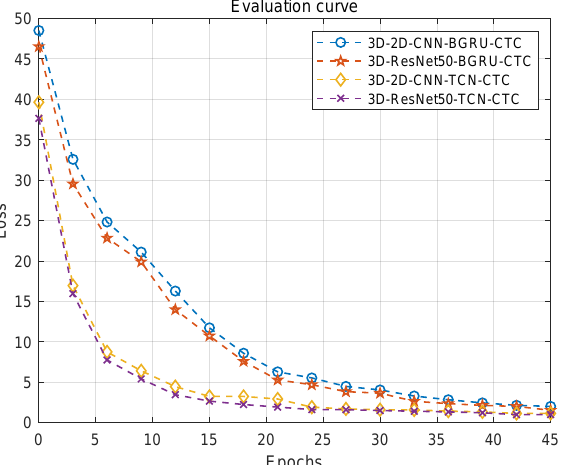
Figure 8. Evaluation curve. Evaluation Loss curves with epochs for four different architectures. Epoch and Loss in the figure respectively represent the number of Epoch and the Loss reached under the